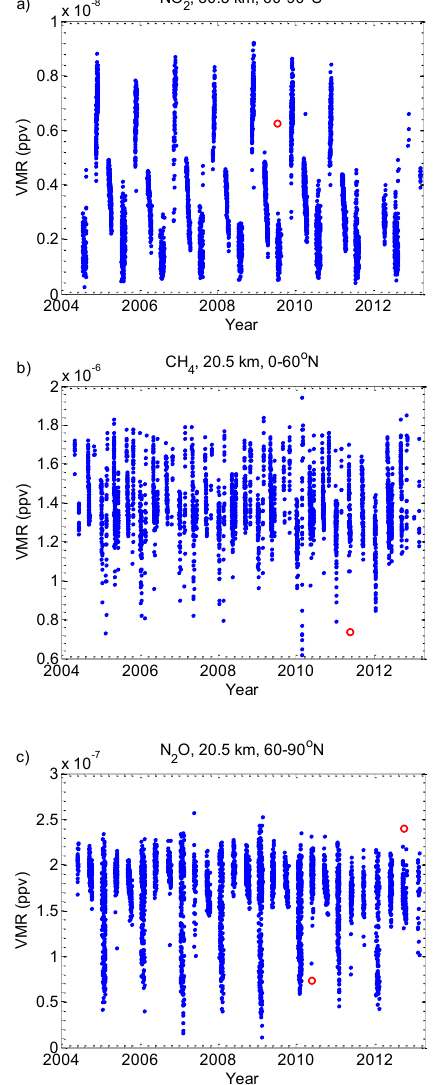
Figure 6. Sunrise ACE-FTS data for the same data subsets as Fig. 4. The red circles are data that have been determined to be unnatural outliers as per the 15 day running median and MeAD, and the blue dots are data that have been determined to be